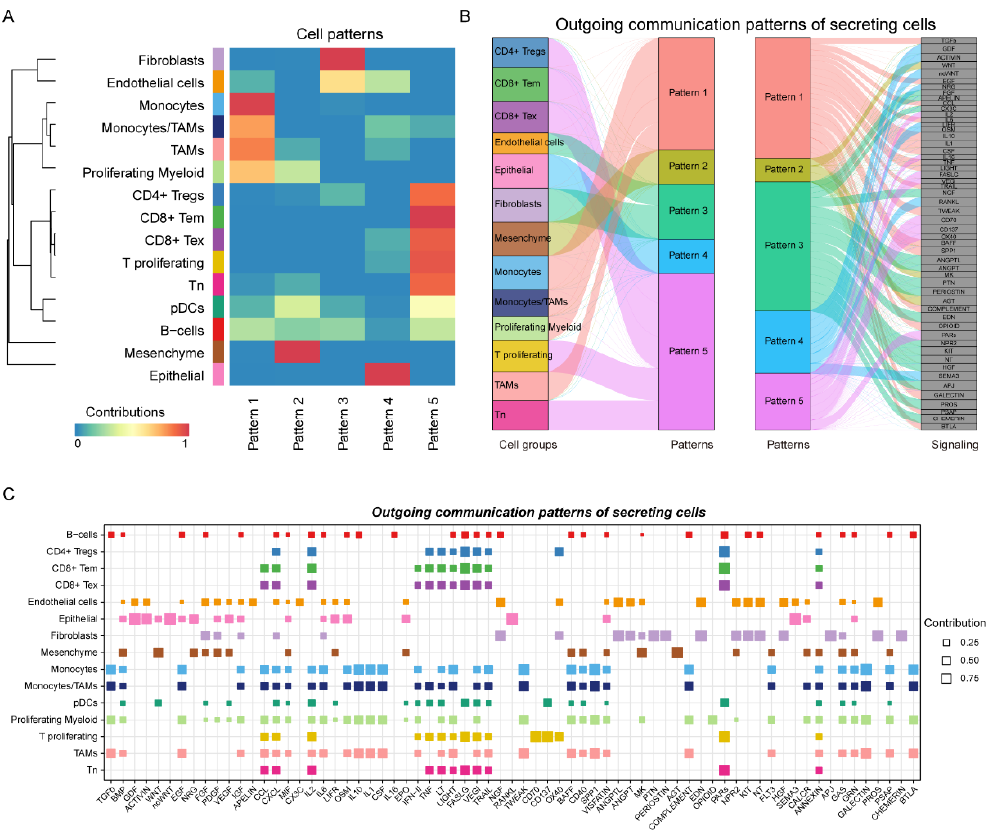
Figure 6. ( A ) Heatmap showing the global five communication patterns calculated by the key sig- nals for subpopulations between cell populations. ( B ) The outgoing communication patterns of se- creting cells, which shows the correspondence between the inferred latent patterns and cell groups, as well as signaling pathways. ( C ) Contribution of cell populations to all signaling pathways. The size of the dot is the proportion of the cell population involved in each of the corresponding signal transmissions.